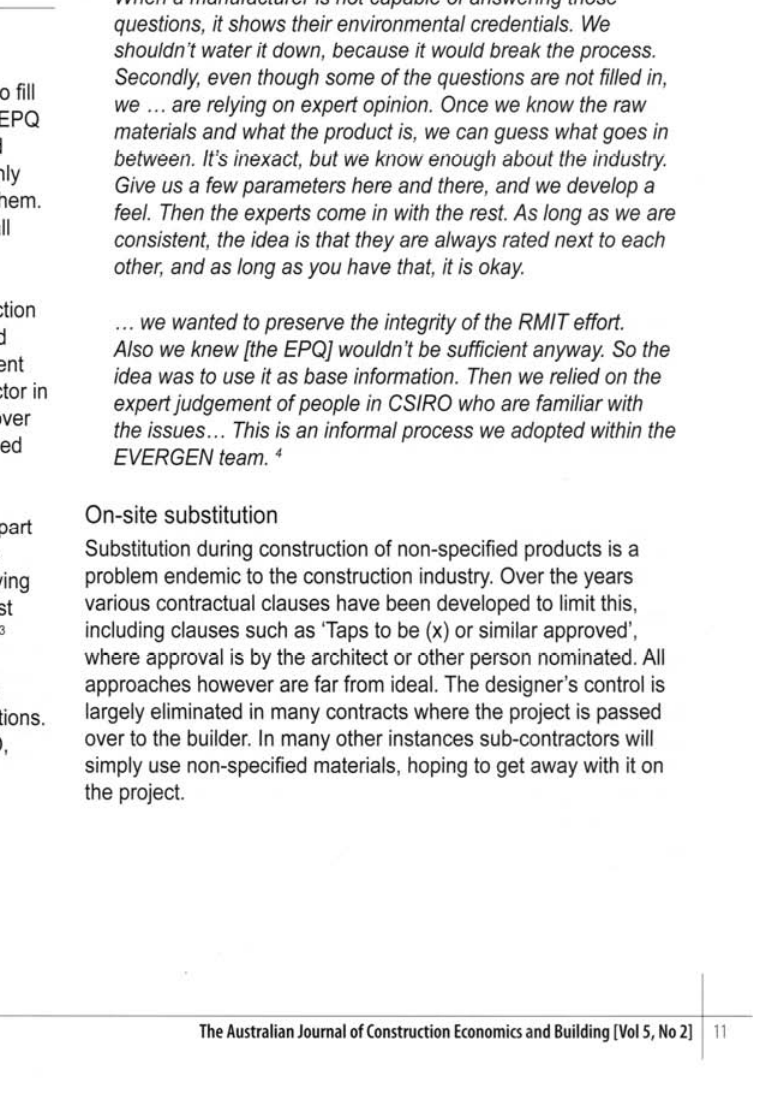
Table 1: Example score sheet (used with permission from